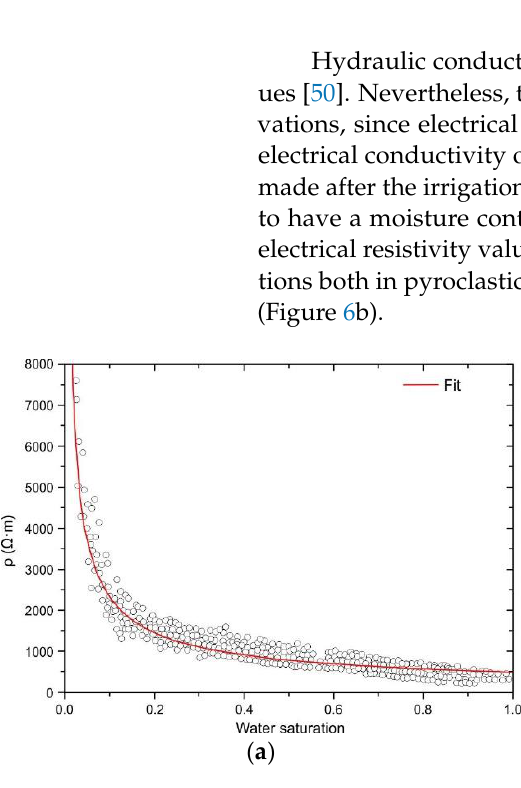
Figure 6. ( a ) Correlation between the electrical resistivity and the degree of saturation of different pyroclastic volcanic soils; ( b ) Correlation between electrical resistivity and degree of saturation of different volcanic soils with ignimbrites. Both correlations have been obtained by the authors of [51].